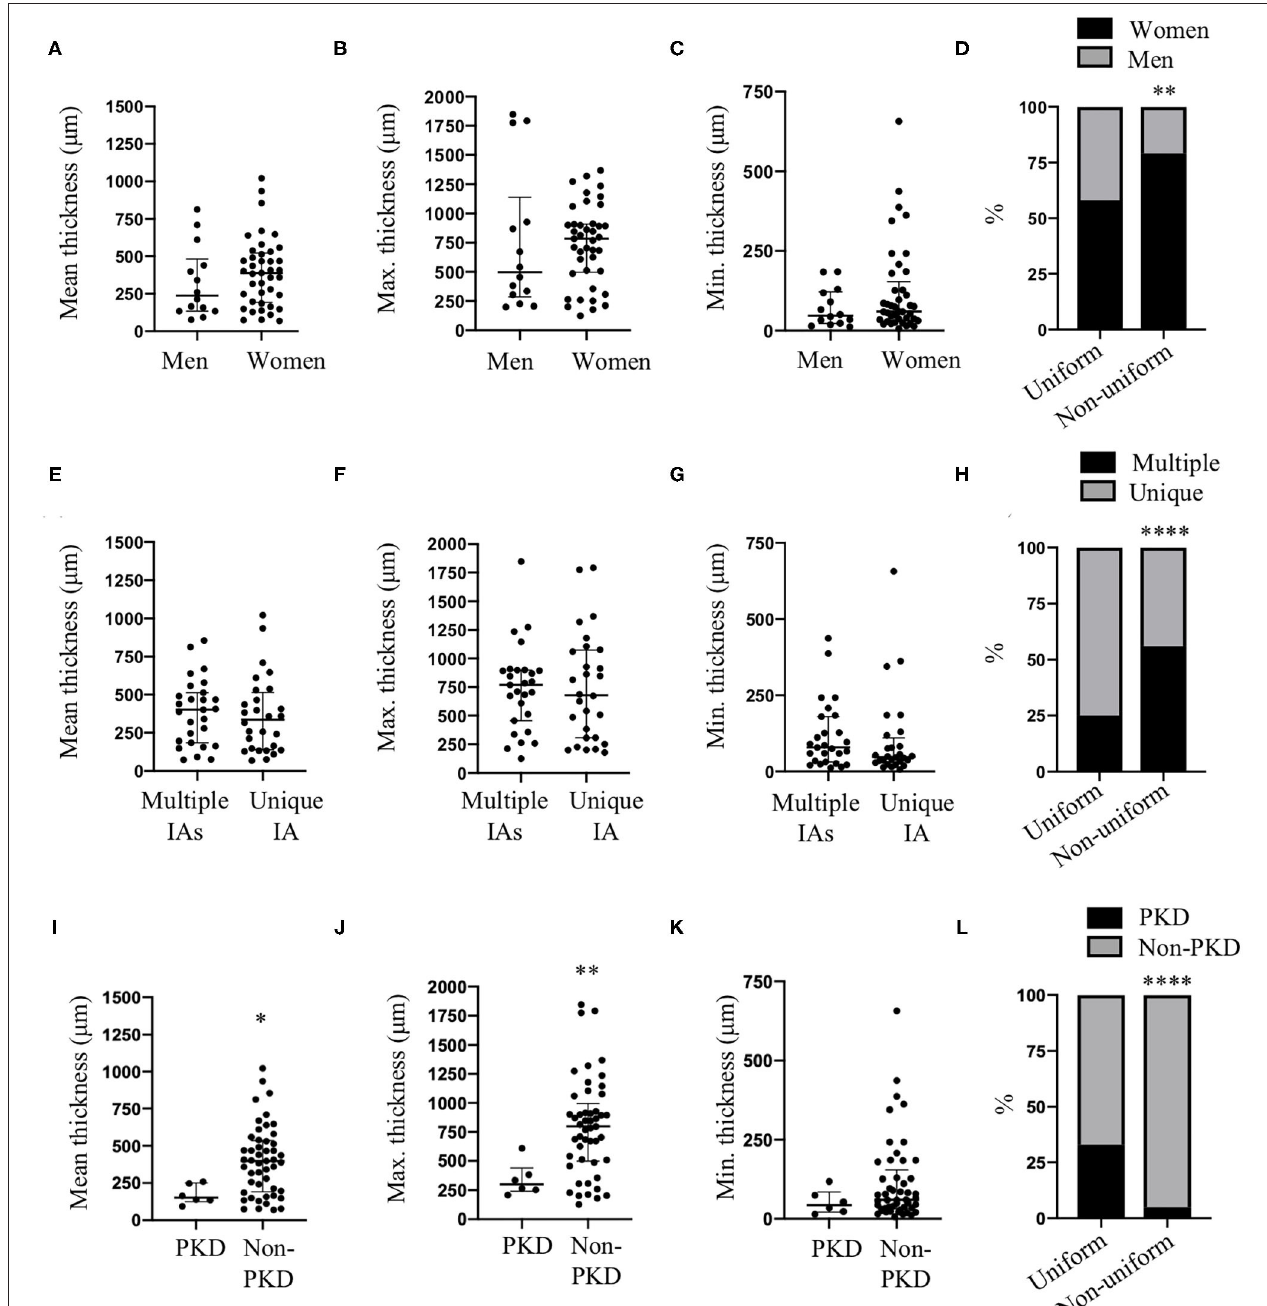
FIGURE 6 | Sex, IA multiplicity and PKD effects on IA wall thickness and uniformity. Mean (A,E,I) , maximum [Max. (B,F,J) ] and minimum [Min. (C,G,K) ] IA wall thickness in men and women (A–C) , for groups of multiple IAs and unique IA (E–G) and in patients diagnosed or not with PKD (I–K) . Data are shown as individual values and as median with interquartile range. * p < 0.05, ** p < 0.01, non-parametric Mann-Whitney U -test. (D) Distribution of women (black) and men (gray) between uniform and non-uniform wall thickness groups. (H) Distribution of multiple IAs (black) and unique IA (gray) between uniform and non-uniform wall thickness groups. (L) Distribution of PKD (black) and non-PKD (gray) patients between uniform and non-uniform wall thickness groups. ** p < 0.01, **** p < 0.0001, Fisher’s exact test.